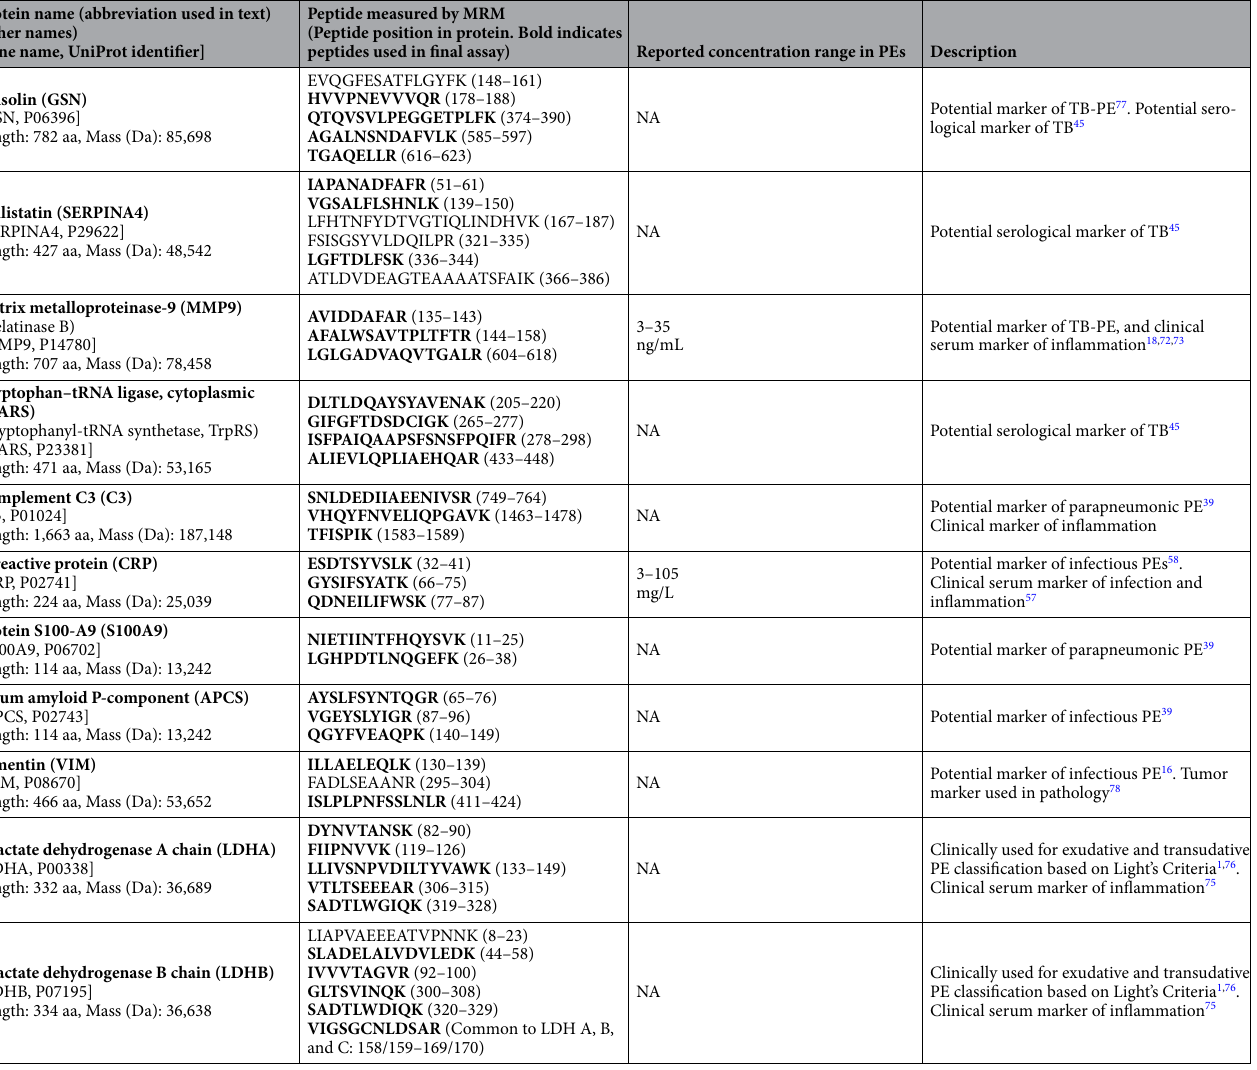
Table 1. Protein markers detected and measured in PE fluid out of fifty-three proteins assessed in this study. Tested proteins but not detected are described in Supplementary Table S2. These consist of markers currently used in the clinic, and putative markers proposed in the research literature, which have shown potential in the diagnosis or classification of PEs, of cancer samples, or disease from plasma/serum testing, using clinically established biochemical or antibody-based assays, or using research techniques such as global and targeted MS or antibody-based single- and multi-plexed methods. Twenty-nine proteins (ADA1 and ADA2